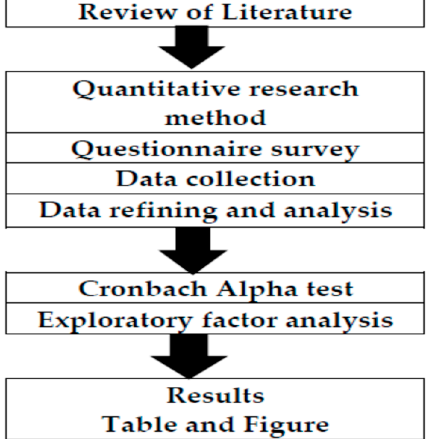
Figure 1. Research methodology adopted for the study.